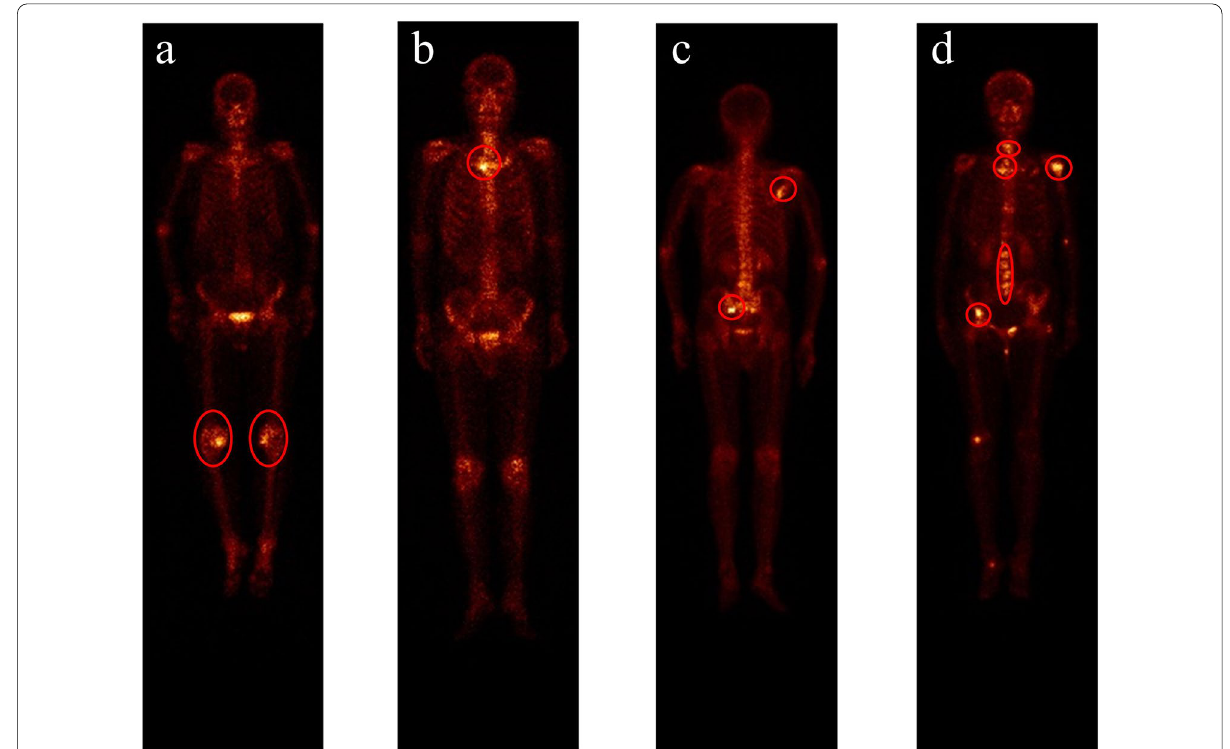
Fig. 11 An illustration of the classified images by multiclass classifier Classifer-inRAC. a NoMet incorrectly detected as metastatic; b ADMet incorrectly detected as nADmet; c Correctly detected nADMet image; and ( d ) Correctly detected ADMet